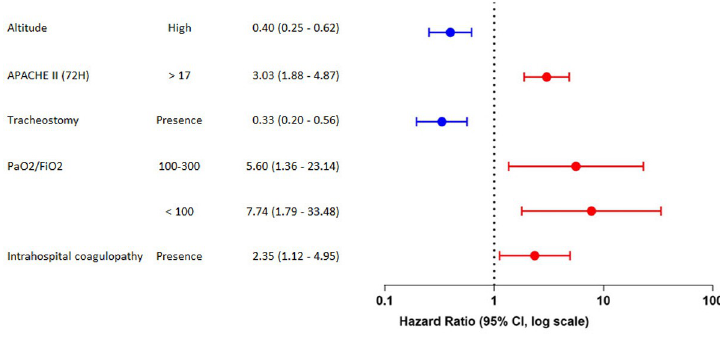
Fig 6. High altitude mortality predictors among COVID-19 patients living at two different altitudes.